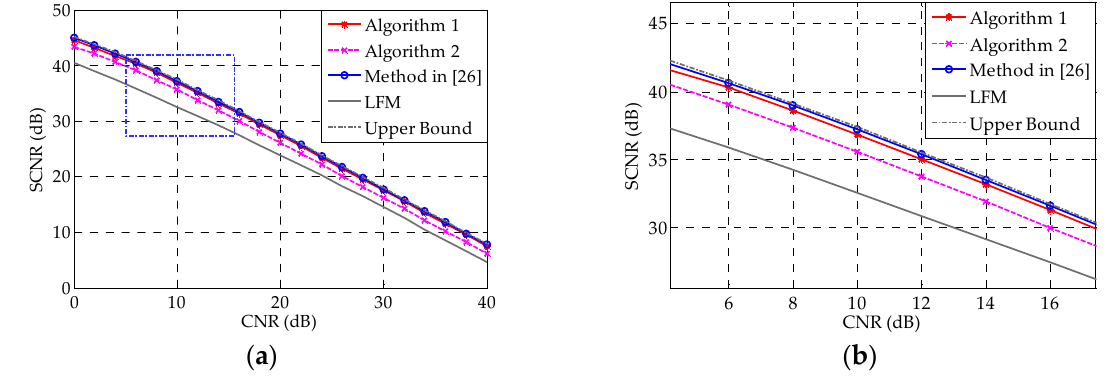
Figure 10. ( a ) SCNR performances vs. CNR for the deterministic target case. The upper bound is the SCNR obtained with 100 iterations of the method in [26], while the blue line marked with circles is obtained with 30 iterations of the same method; ( b ) Zoomed version of the box highlighted in ( a ).